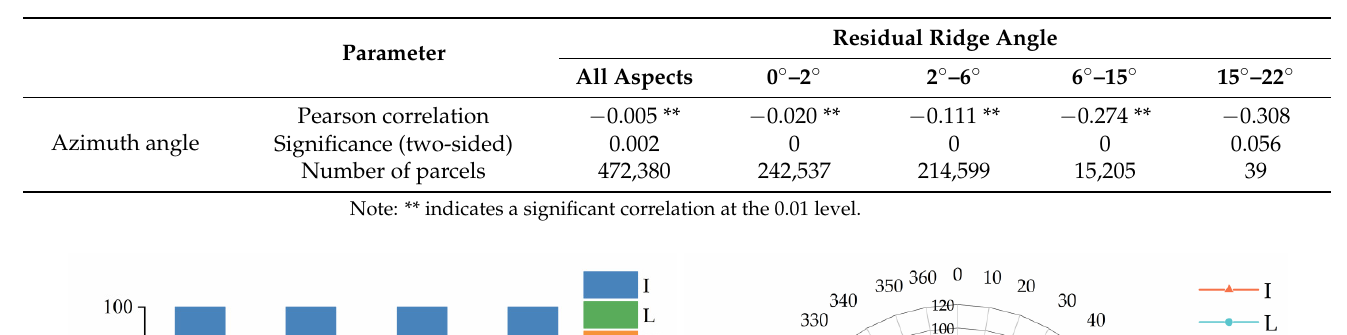
Table 3. Correlation between azimuth angle and ridge orientation for different slope gradients.